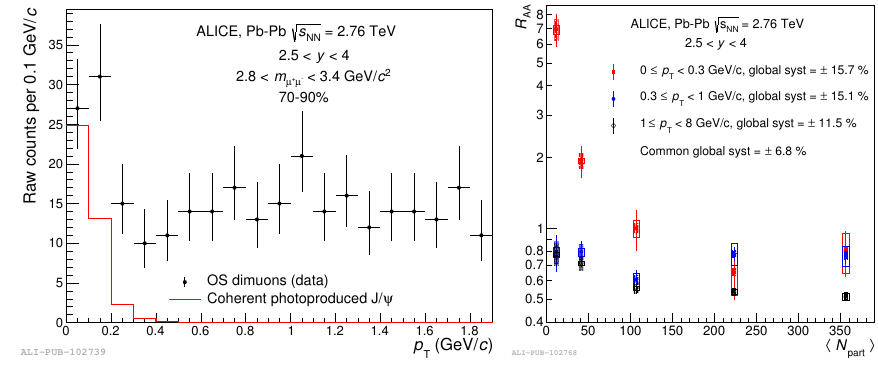
Figure 11. Left: transverse momentum spectrum for J /ψ at forward rapidity in peripheral Pb–Pb √ s NN = 2 . 76 TeV. Right: J /ψ nuclear modification factor as function of the number of collisions at participants in di ff erent transverse momentum bins [22]